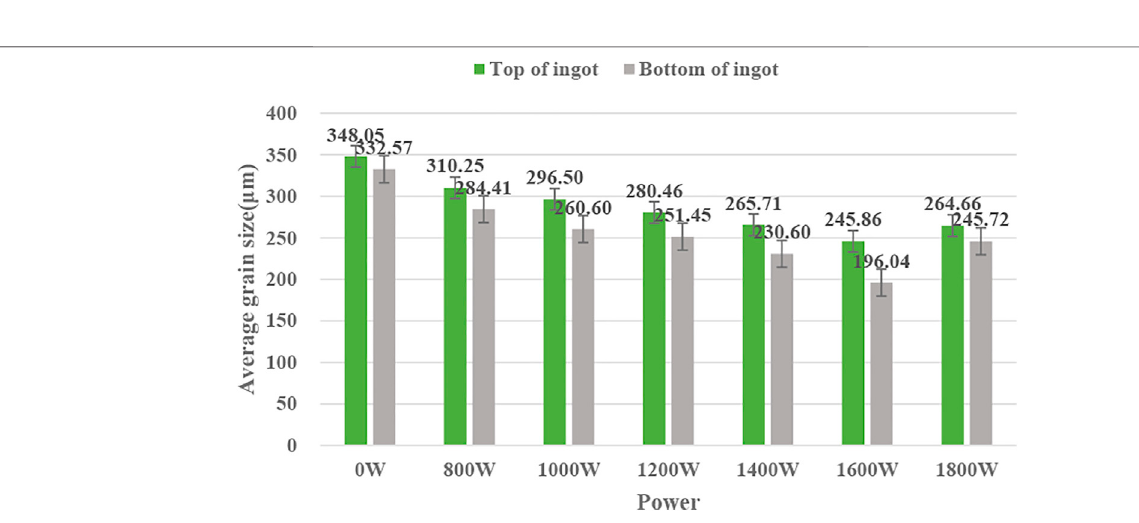
Frontiers in Materials |